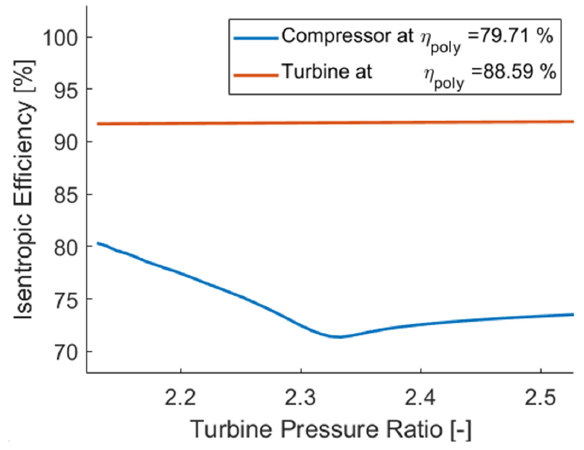
Figure 20. Isentropic efficiency of turbine and compressor of S-CO 2 Brayton cycle.